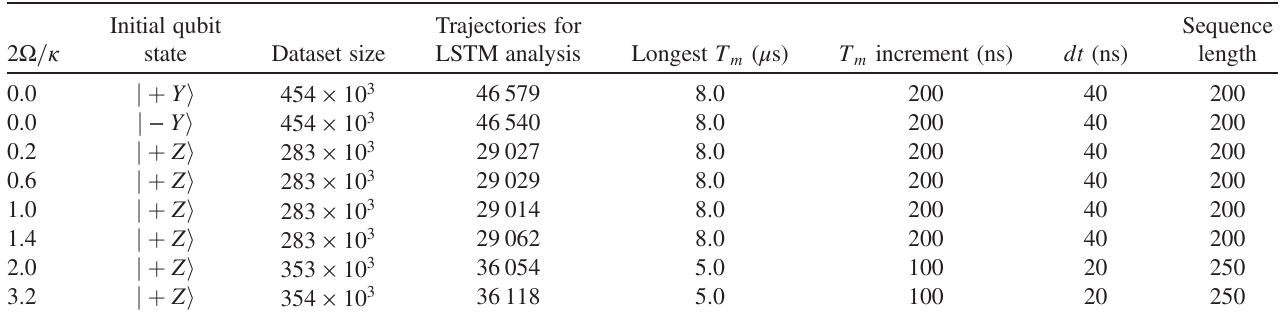
), the m and dt . Note that all voltage records within a m are zero m